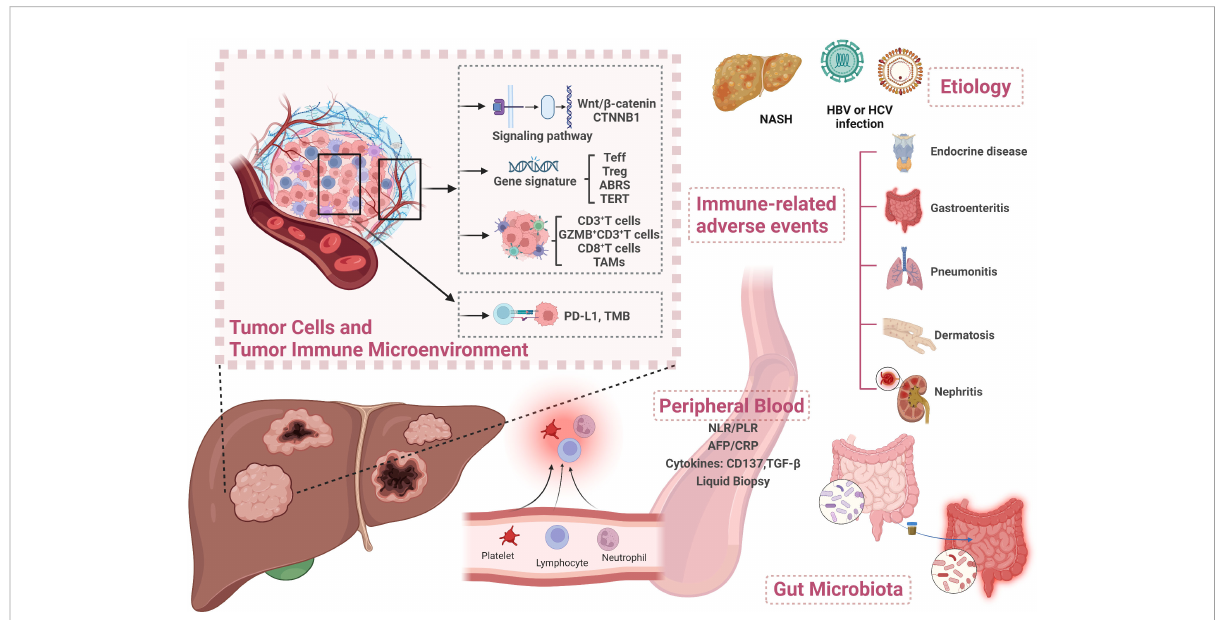
FIGURE 1 Overview of biomarkers for predicting treatment response to immunotherapy in HCC. Created with BioRender.com. Teff, T effector; ABRS, atezolizumab + bevacizumab response signature; TAM, tumor-associated macrophage; PD-L1, programmed death ligand 1; TMB, tumor mutational burden; NLR, neutrophil-to-lymphocyte ratio; PLR, platelet-to-lymphocyte ratio; AFP, alpha-fetoprotein; CRP, C-reactive protein; TGF- b , transforming growth factor- b ; HBV, hepatitis B virus; HCV, hepatitis C virus; NASH, non-alcoholic